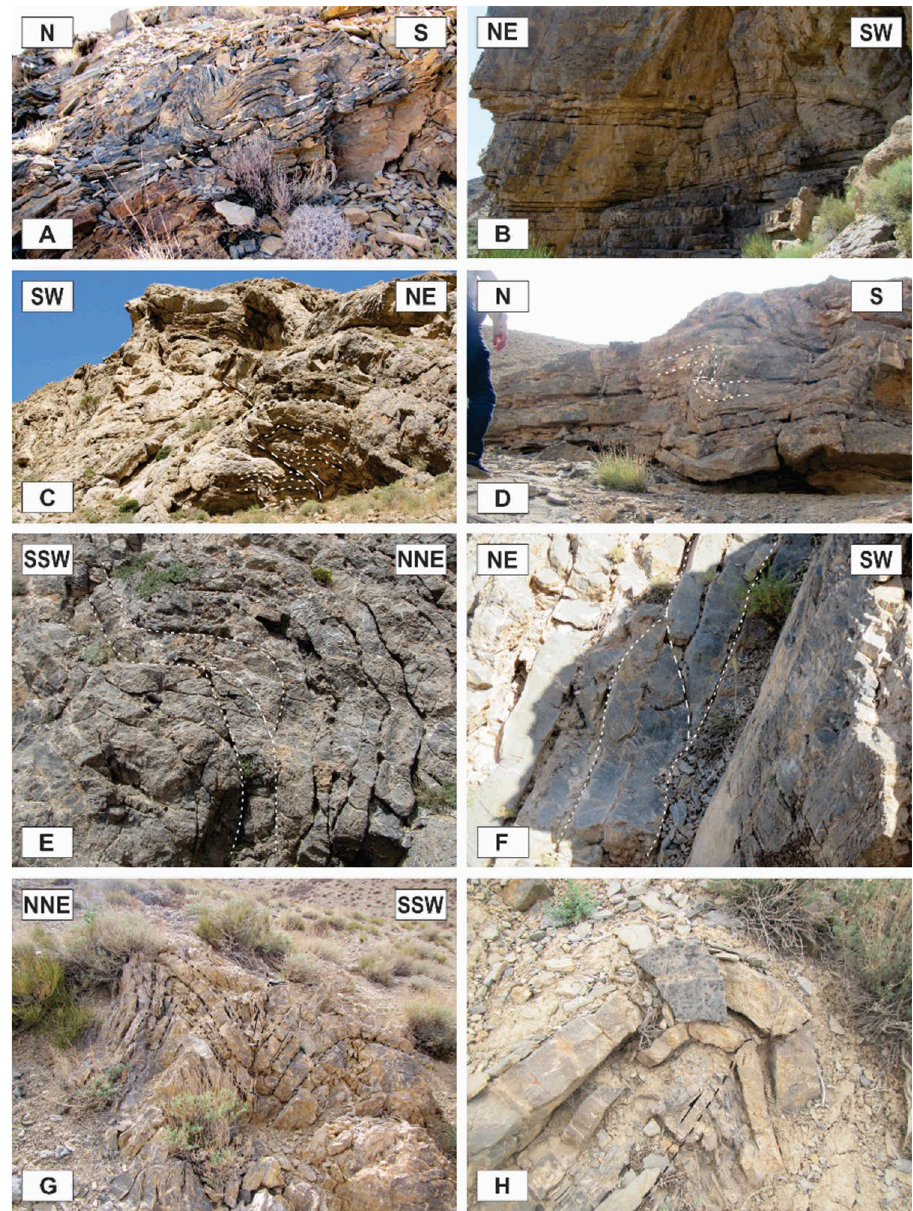
Figure 12. Annotated field photograph of some of the outcrop-scale fold-accommodation faults. ( A ) and ( B ) Back thrusts. ( C ) A Forelimb thrust. ( D ) A forelimb space-accommodation thrust. ( E ) A hinge wedge